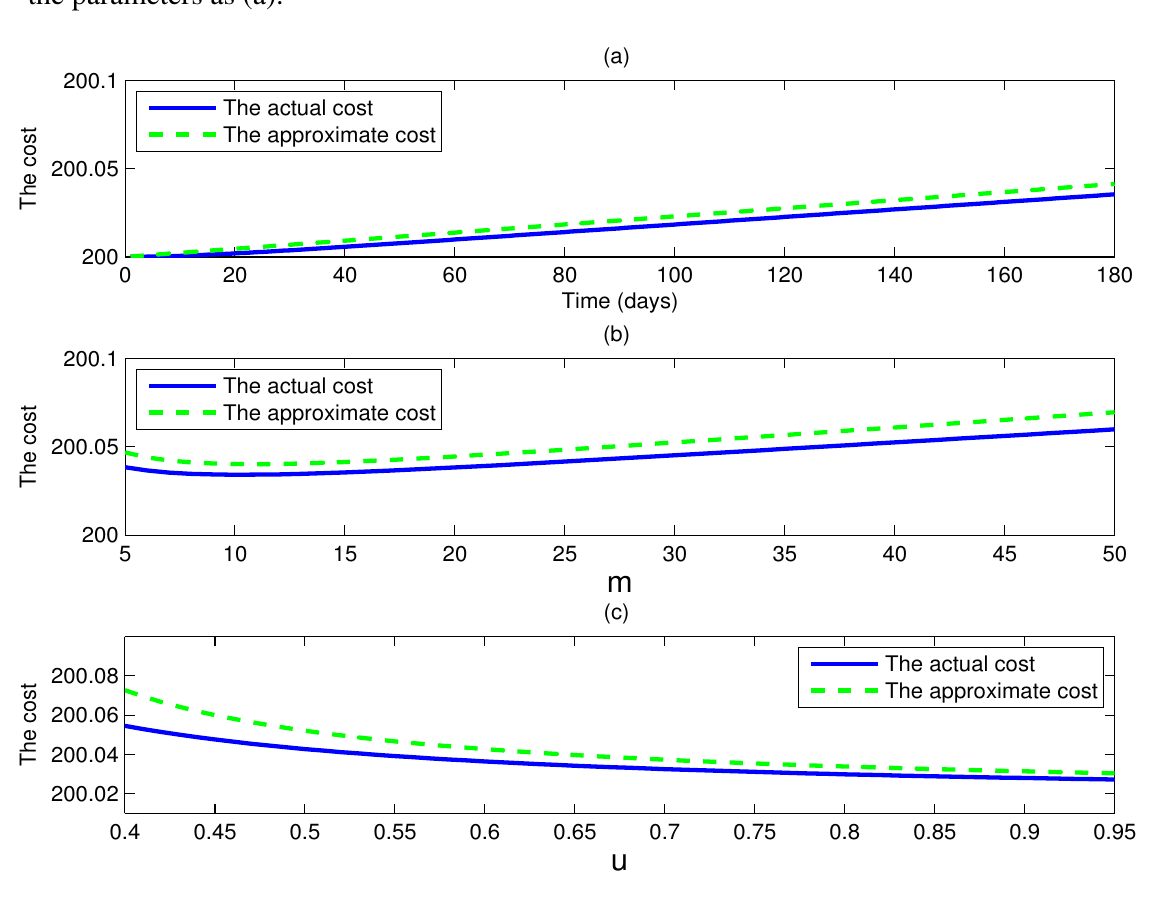
= 1 , c = 50 , c = 100 1 2 3